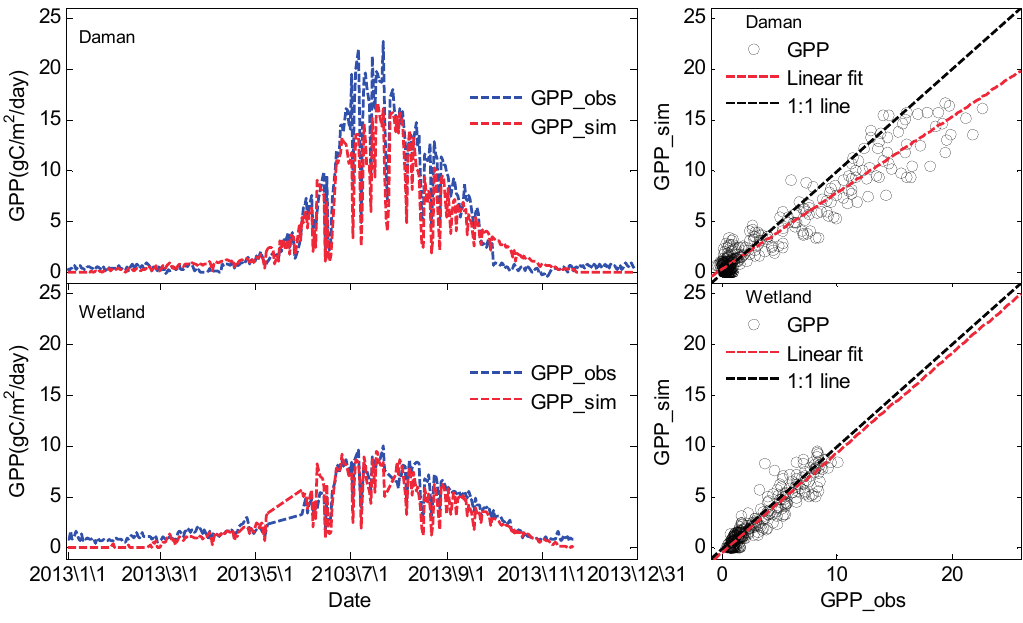
Figure 6. Validation of the GPP estimated by the RS-CFLUX model at the Daman superstation (Daman) and Zhangye wetland station (Wetland). The slope and residual of the linear fit are shown in Table